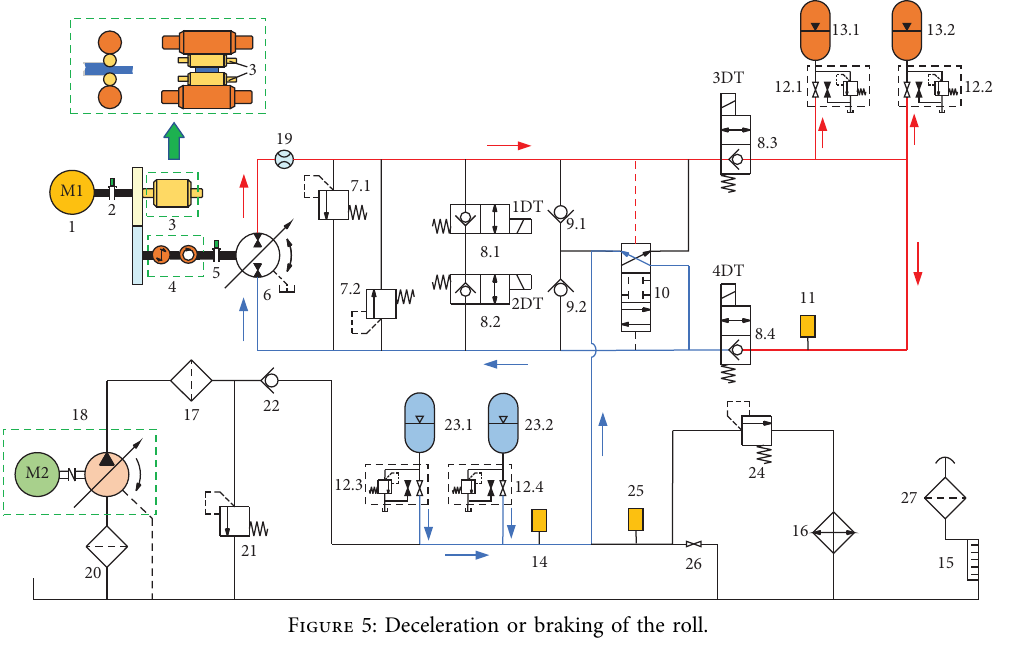
Figure 5: Deceleration or braking of the roll.